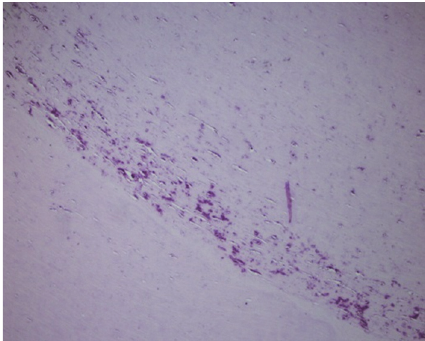
Figure 2: Benign mesenchymal cells and inflammatory elements with a few calcifications periphery of the material are remarkable (H&E ×